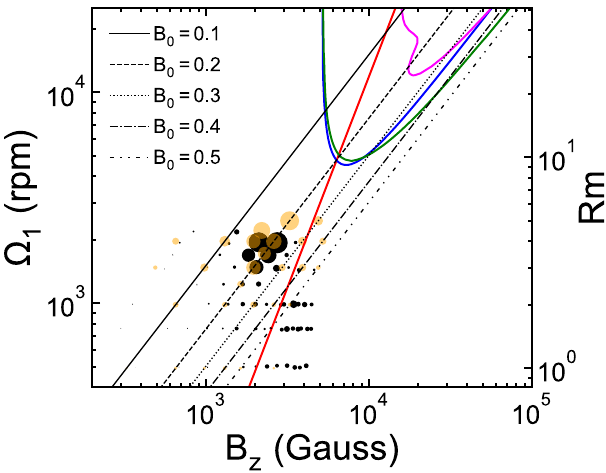
Fig. 8 | Comparison with linear theory predictions for SMRI. Bubble plot of the instability strength from experiments (black bubbles) and 3D simulations (orange bubbles) in the Ω 1 - B z plane with Rm shown on the right. The data are the same as thoseinFig. 3. The blue curve representstheboundaryofthe m =0SMRI fromthe WKB analysis, which is unstable in the parameter space it encloses. The green and magenta curves represent the boundaries of the m =0 and m =1 SMRI from the global linear analysis, respectively. The red line represents Λ =1 using Eq.